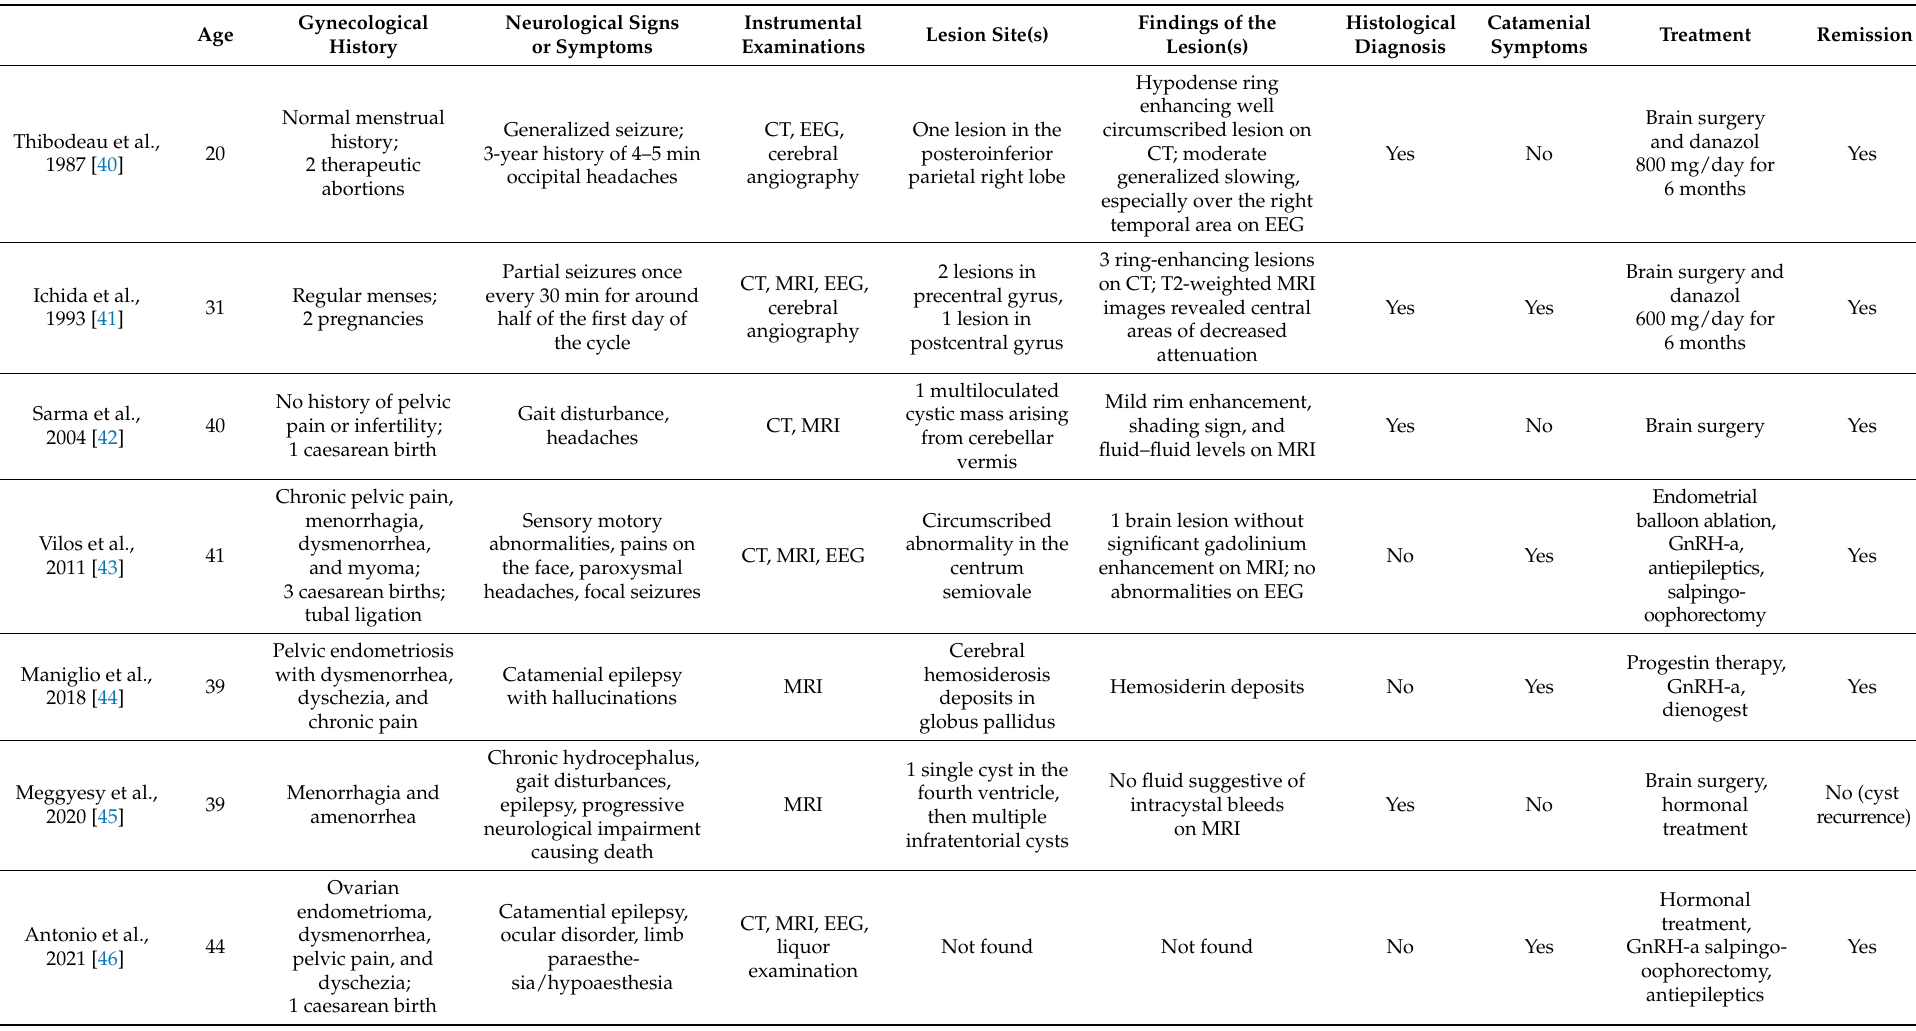
Table 1. Case reports of patients with documented or presumed cerebral or cerebellar